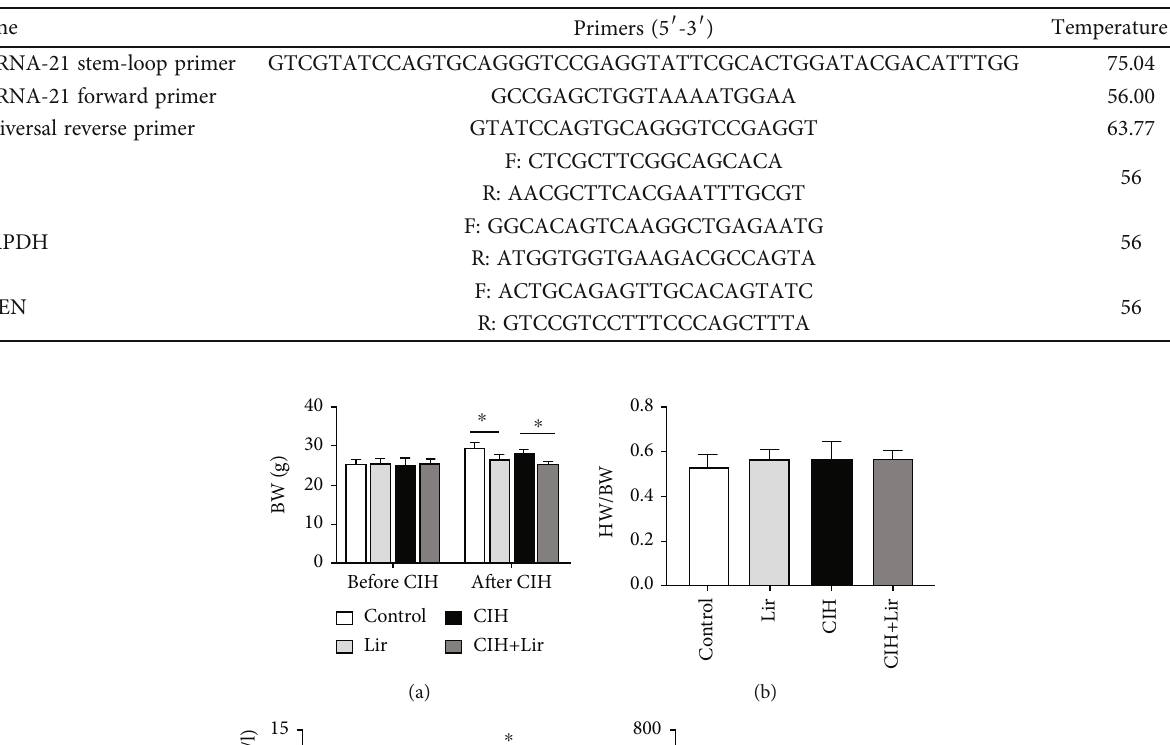
Table 1: Primers used for real-time PCR.